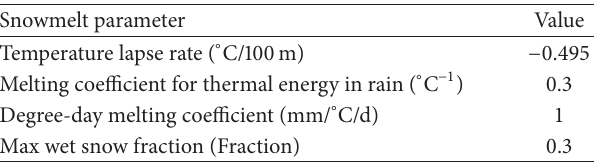
Table 1: Final parameters used for the snowmelt